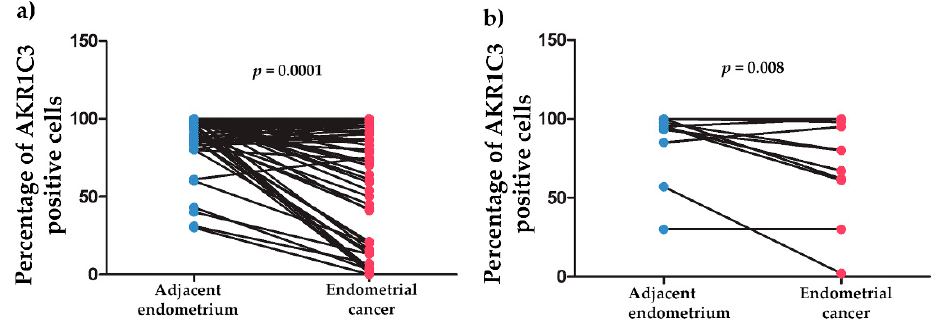
Figure 3. AKR1C3 immunohistochemistry expression in endometrial cancers and the surrounding nonneoplastic endometrium. ( a ) Surrounding nonneoplastic endometrium ( N = 61, mean = 89.5, median = 95.0, IQR = 13.8) compared to endometrioid endometrial cancer ( N = 61, mean 66.2, median 83.0, IQR = 67.0). ( b ) Surrounding nonneoplastic endometrium ( N = 11, mean = 86.1, median = 95.0, IQR = 15.0) compared to nonendometrioid endometrial cancer ( N = 11, mean = 70.4, median = 80.0, IQR = 37.0); IQR, interquartile range; N, number of patients.